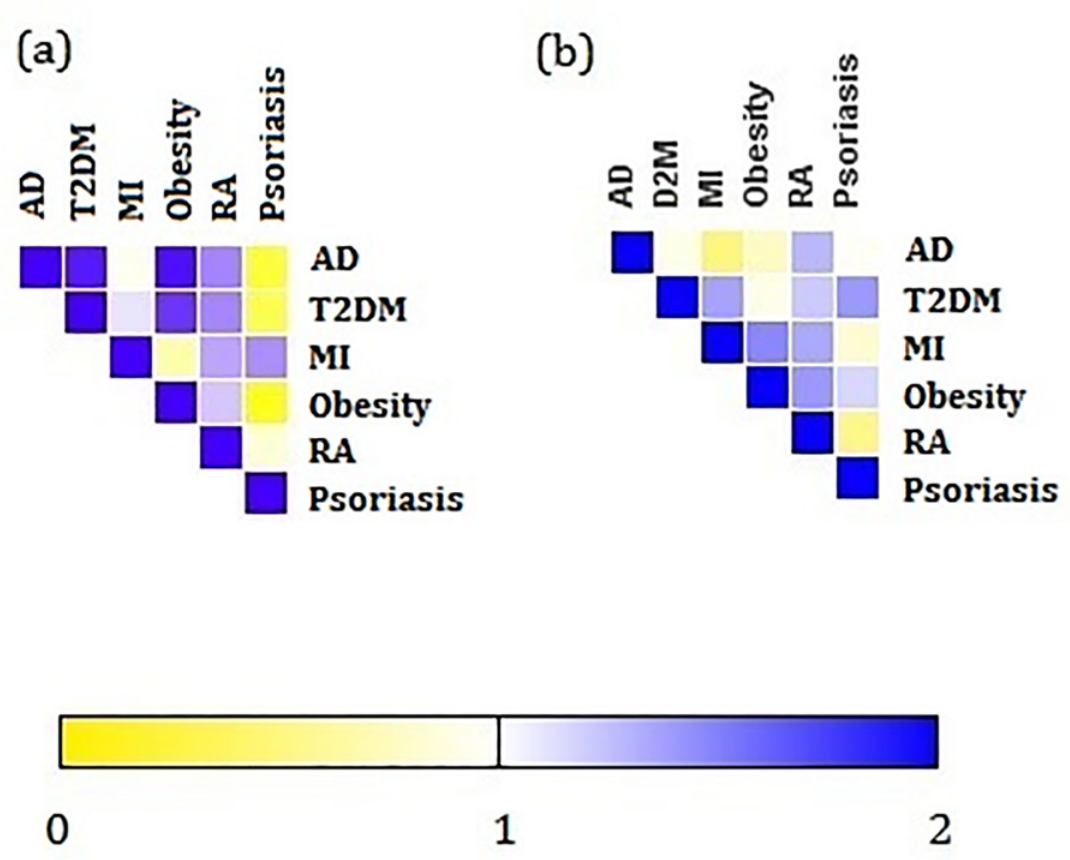
Fig 9. Similarity between psoriasis and its comorbidities. Each cell is colored according to the Jaccard correlation coefficient which represents the similarity between the comorbidities considering, (a) biological process and (b) biological pathways. The MI shares the highest JC in biological process with psoriasis and T2DM shares the highest JC in pathway annotation